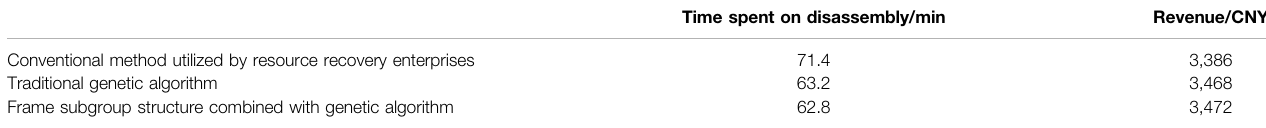
TABLE 4 | Brief results of the experiment